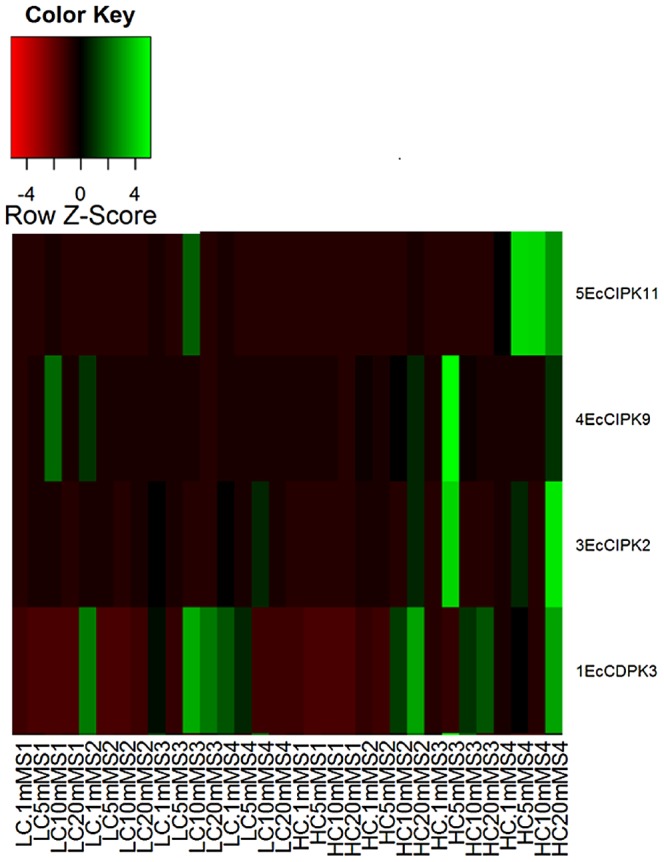
Expression profiles of selected Calcium sensor genes in developing spikes of GP-1 (LC) and GP-45 (HC) exposed to different doses of calcium (0.1 mM, 5.0 mM, 10 mM & 20 mM) as indicated by qPCR analysis.The scale representing the relative signal intensity values is shown above. The different stages of developing spikes are S1 (spike emergence); S2 (pollination stage); S3 (dough stage) and S4 (maturation).